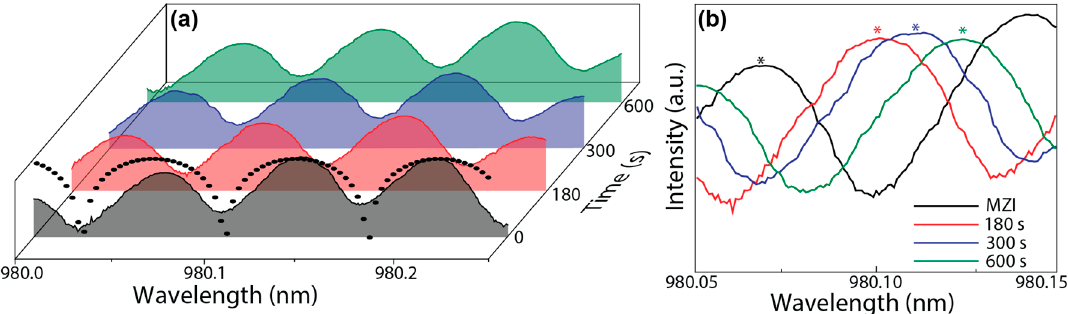
Figure 4. ( a ) Simulated (solid circles) and experimental transmission spectra of the MZI and the respective temporal dependence after the fluid spread in the sensing region for selected time intervals; ( b ) magnification of the spectral region used to estimate n F .